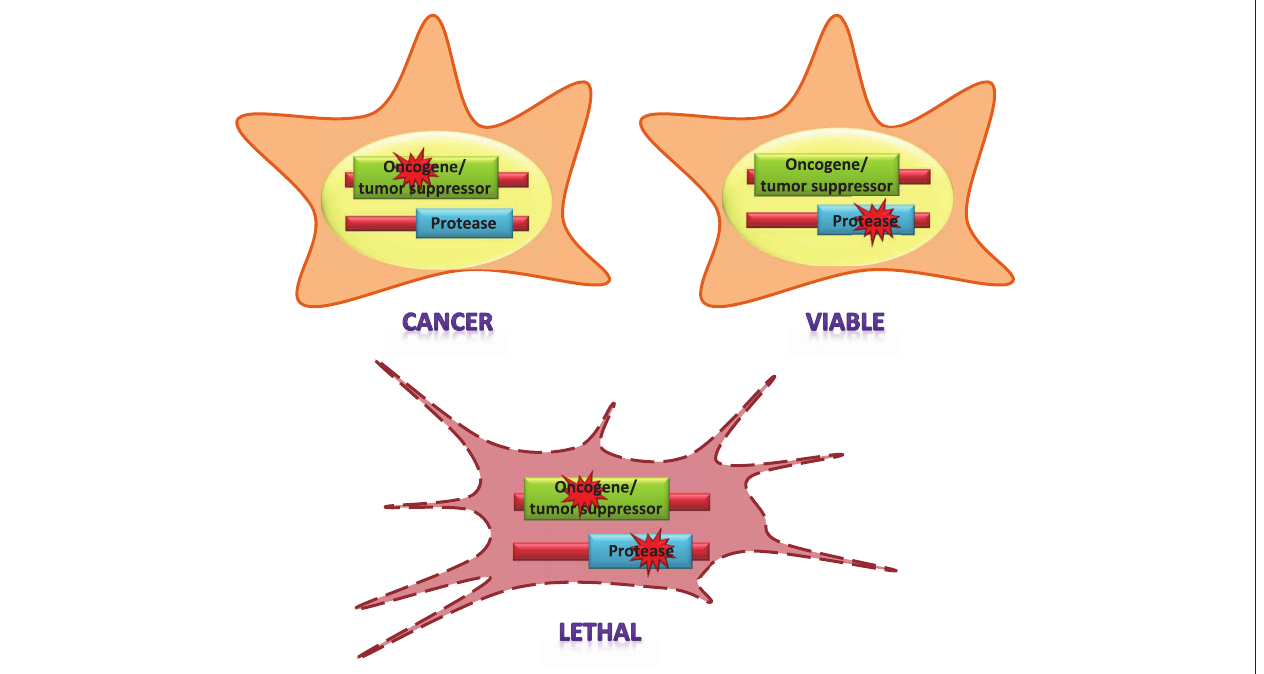
Figure 2 | The concept of synthetic lethality applied to the interactions of proteases and cancer genes. Mutations in oncogenes and tumor suppressor genes act as drivers of neoplastic transformation. A protease is “synthetic lethal” with an oncogene or a tumor suppressor gene if its